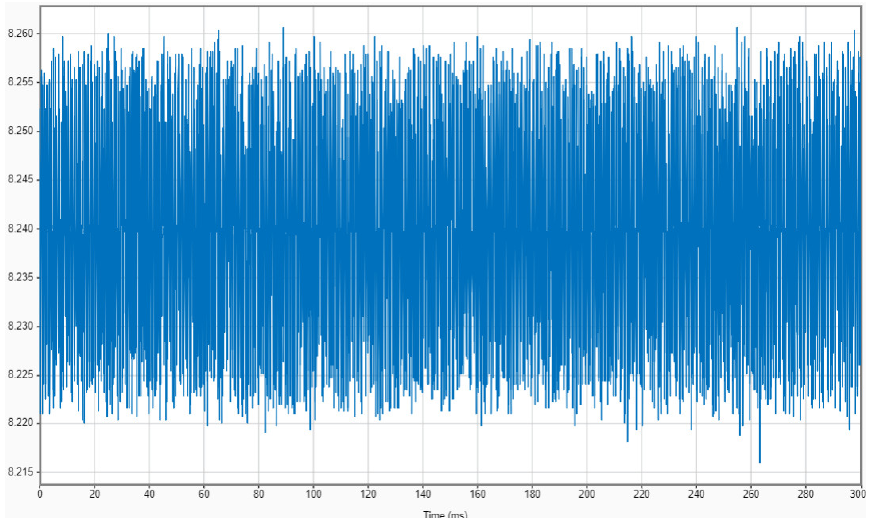
Figure 2. AE signal vs. time during one grinding pass (Test No. 1).